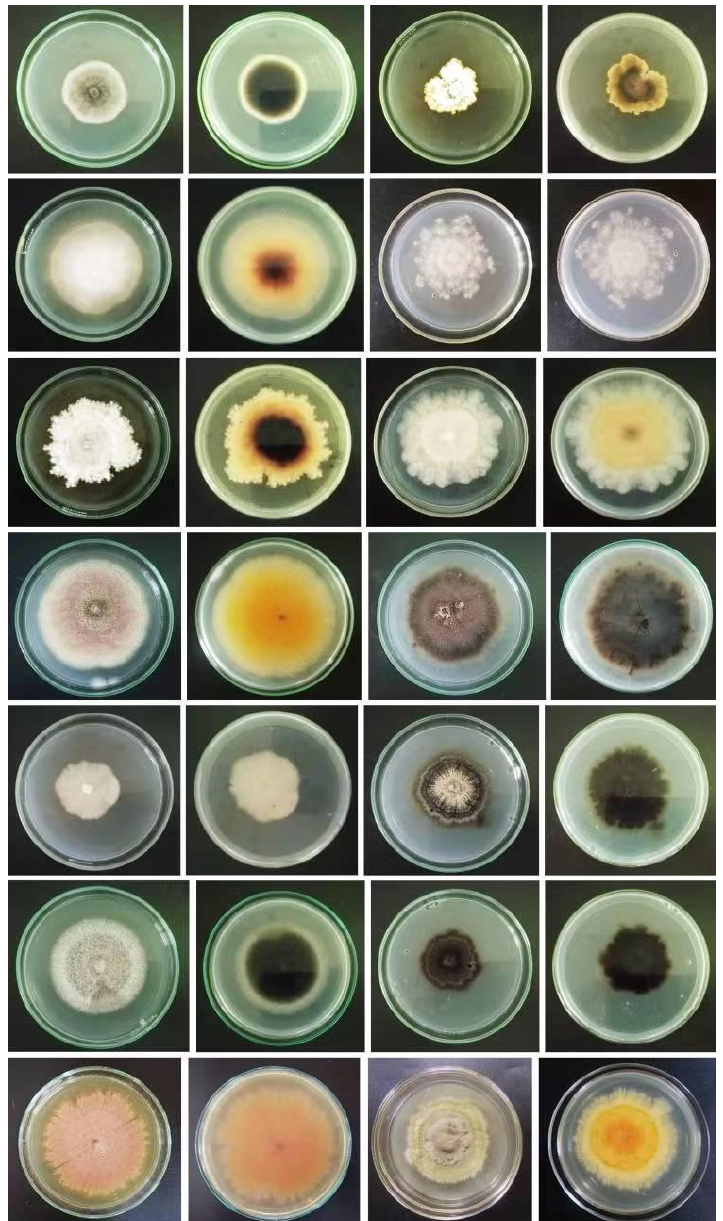
Figure 7. Endophytic and epiphytic fungi isolated from four seagrass species at Kalpitiya lagoon, Sri Lanka (molecular characterization of these taxa is still being carried out faithfully by Rajakaruna et al., though unpublished) (courtesy of Oshadhi Rajakaruna, Faculty of Science, University of Colombo, Sri